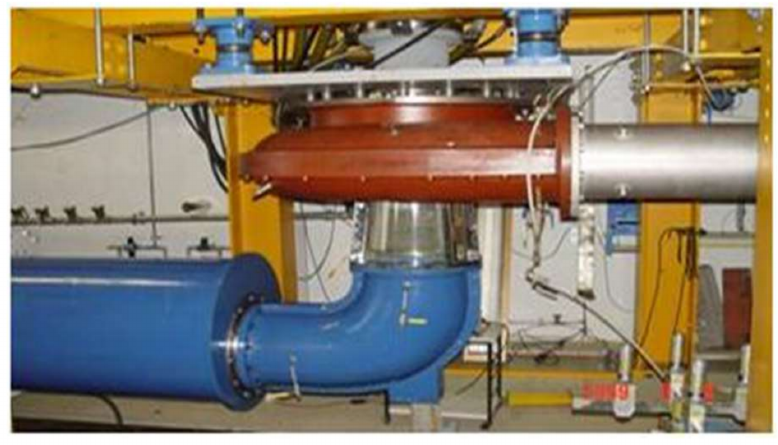
Figure 7. Pump turbine experimental